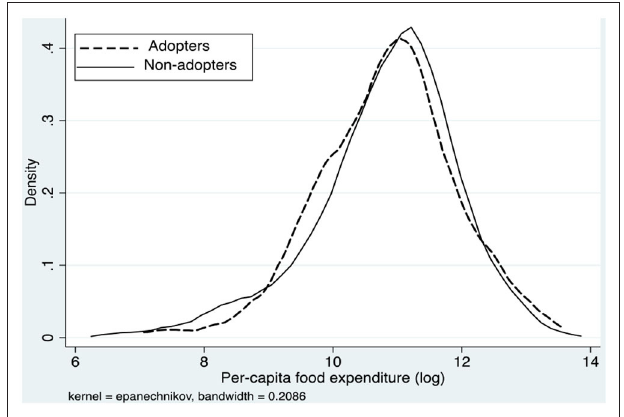
FIGURE 2 | Kernel density distribution of the log of per-capita total house expenditure for adopters and non-adopters of organic fertilizers.